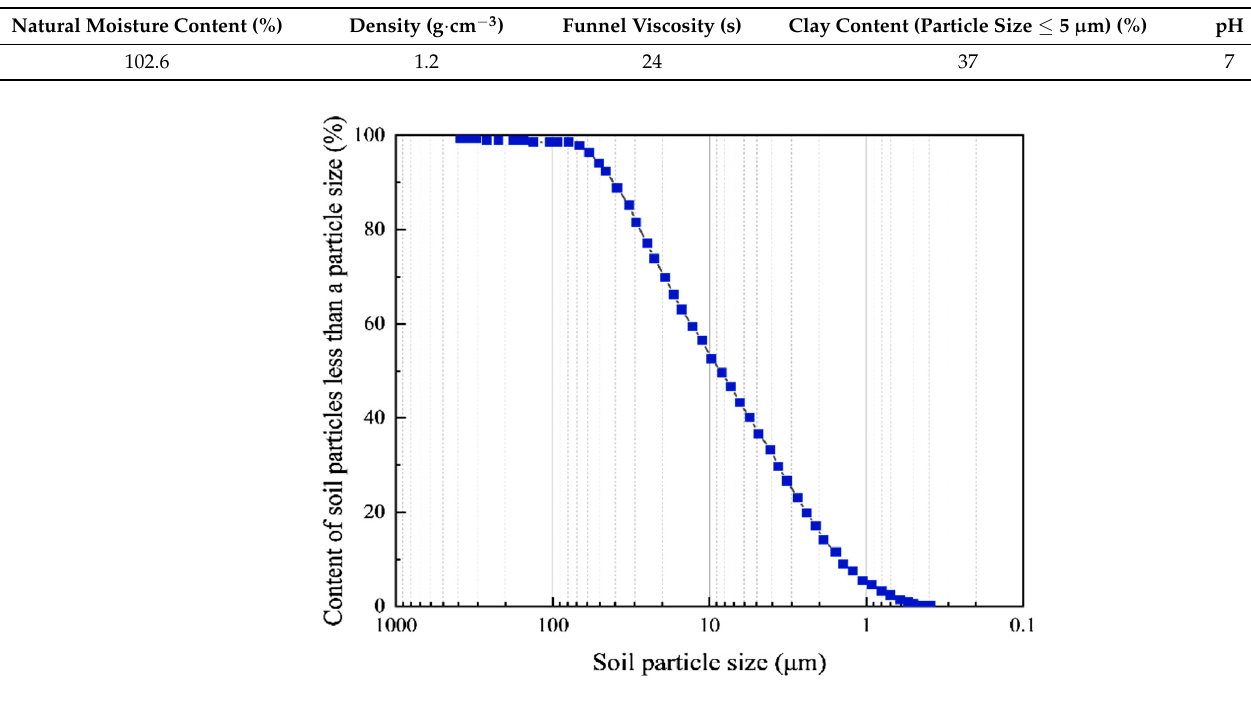
Figure 1. Geological conditions of mud sampling. Table 1. Basic properties of the mud.